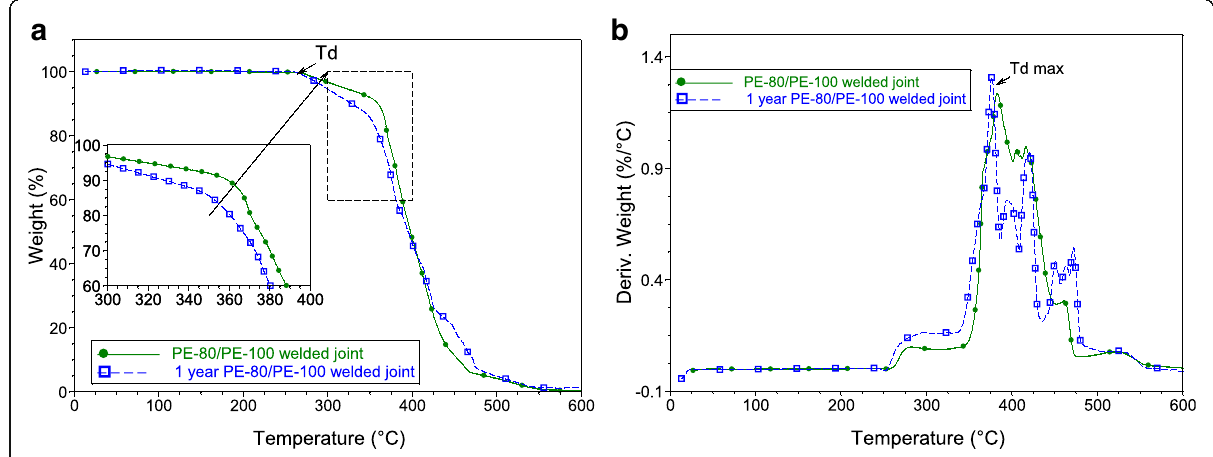
Fig. 6 Result of TGA study. Relative weight ( a ) and derivate weight on temperature ( b ) of PE-80/PE-100 welded